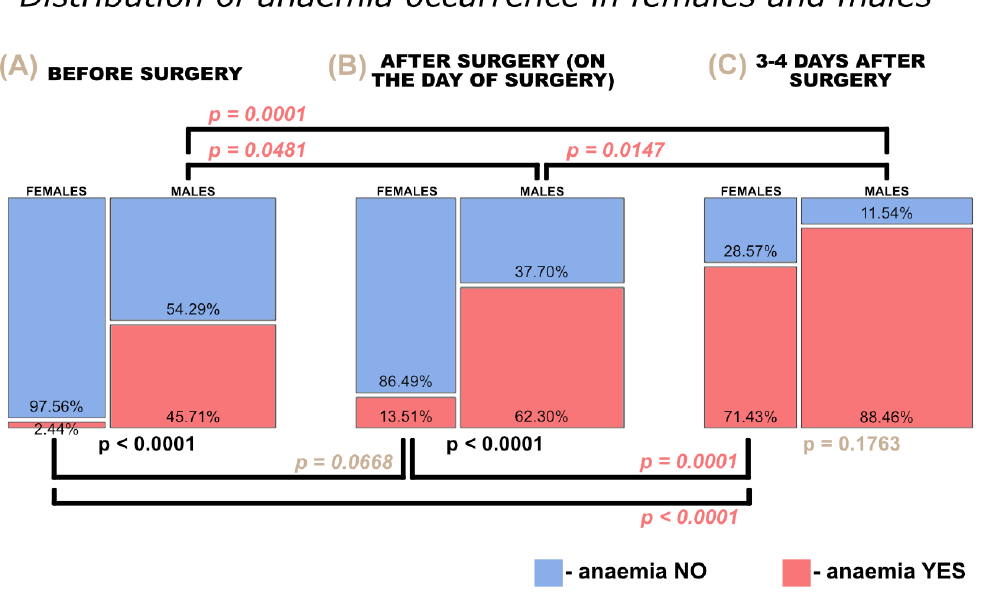
Figure 1. Comparison of anaemia prevalence in women and men ( A ) before surgery, ( B ) after on the day of surgery, and ( C ) 3 – 4 days after surgery. day of surgery, and ( C ) 3–4 days after